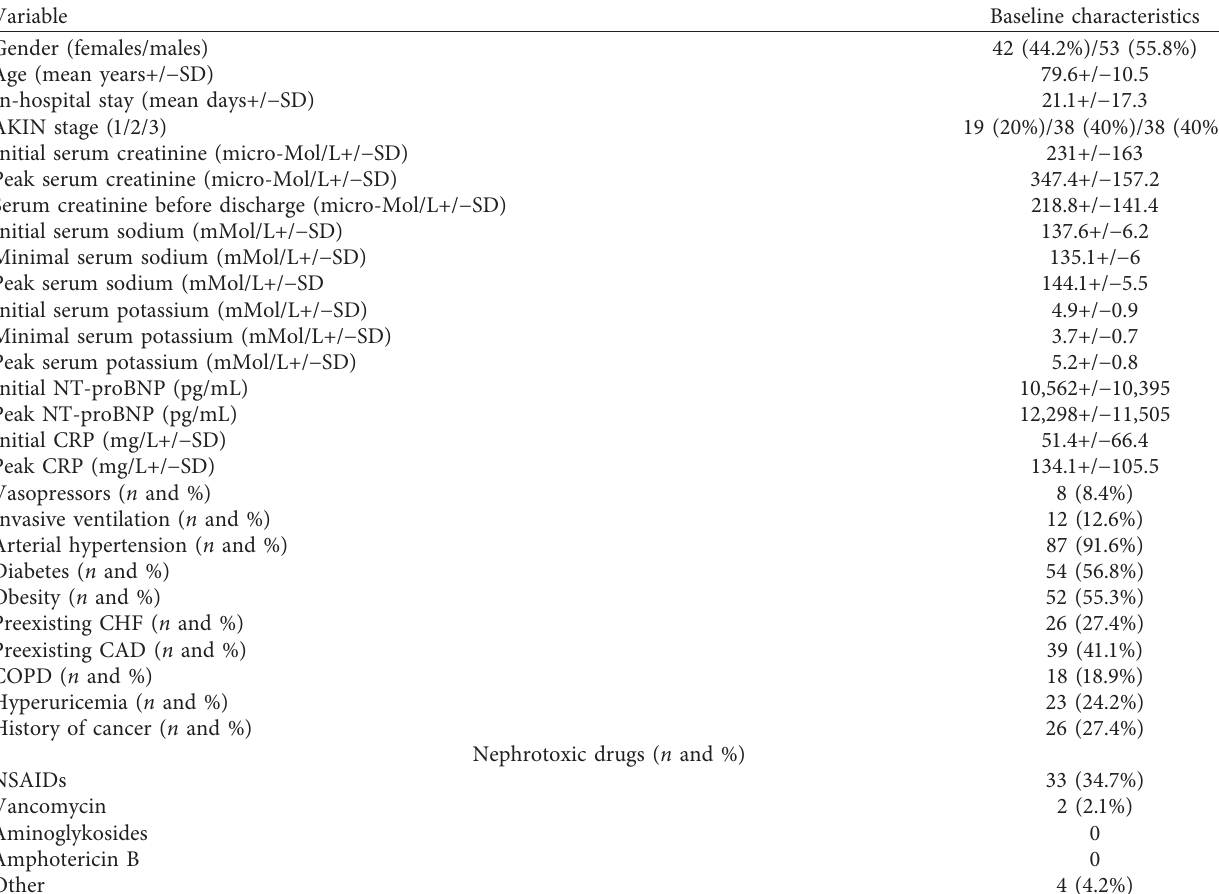
Table 1: Baseline characteristics of all patients